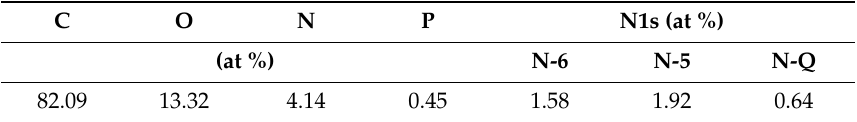
Table 3. Element content of fibrous networks prepared from PAA-12.9% PDPP through different thermal treatments.